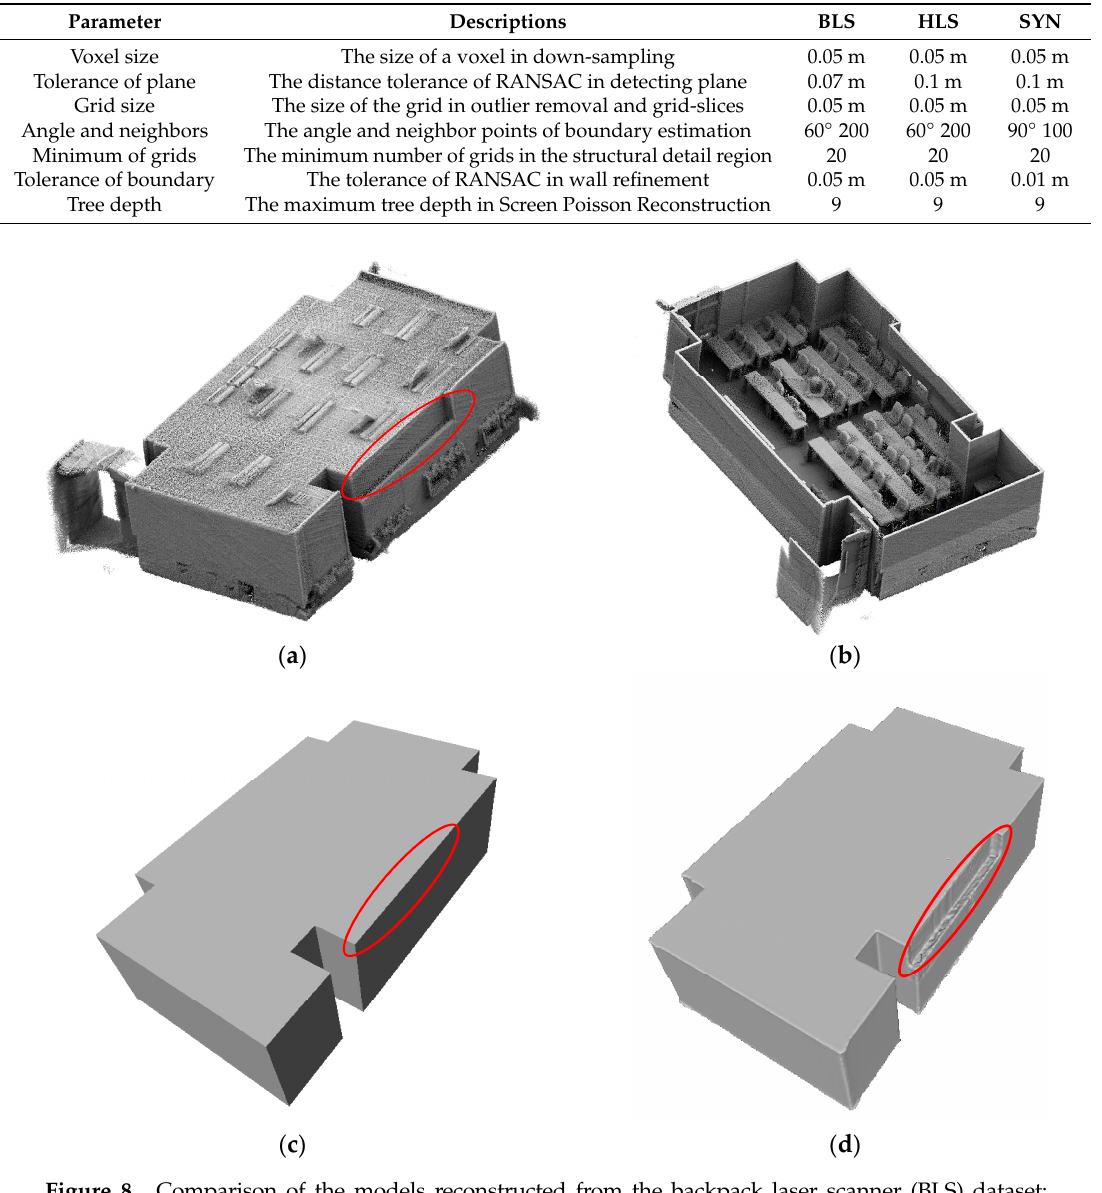
Figure 8. Comparison of the models reconstructed from the backpack laser scanner (BLS) dataset: ( a ) raw point cloud dataset (the detailed structure points are in the red circle), ( b ) raw point cloud dataset without ceiling, ( c ) model generated from Shi’s approach (the detailed structure is ignored in the red circle), ( d ) model generated from our approach (the detailed structure is reconstructed in the red circle).